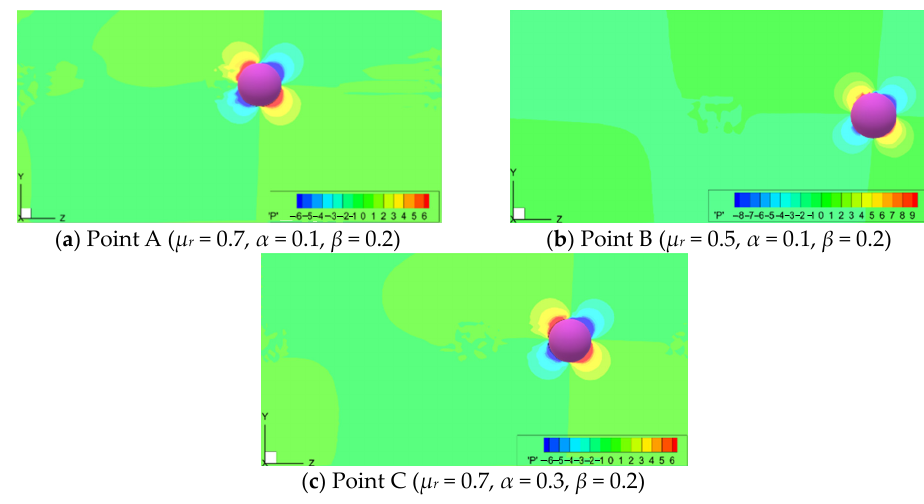
Figure 9. Pressure contours for three cases in Figure 7 (Wi = 0.3).